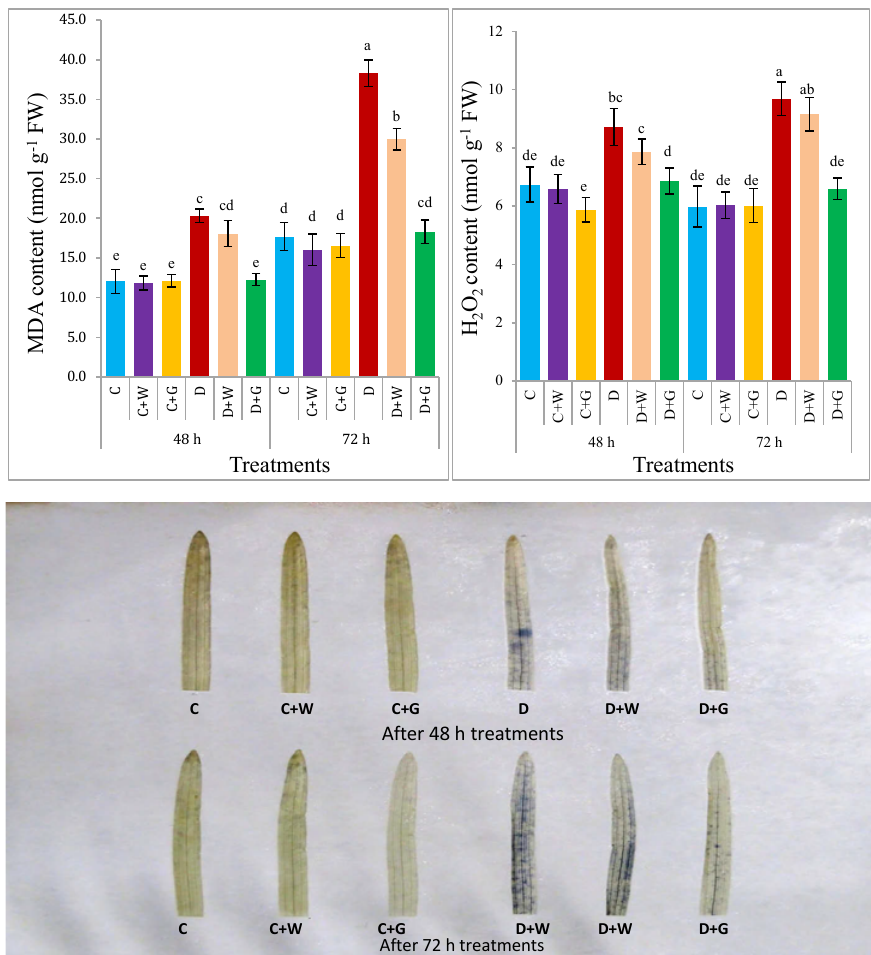
Fig. 2 Effect of drought stress and exogenous GA on MDA and H 2 O 2 concentrations and accumulation of O 2•− in wheat seedlings. Codes are as for Fig.